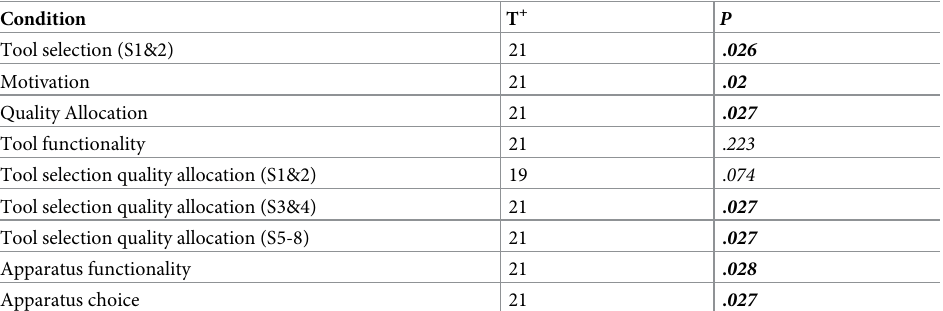
Table 1. Performance across all conditions for the crows across both apparatuses. Results reflect results of Wil- coxon 1-sample signed ranks tests–chance value = 50%. Significant p-values ( < .05) highlighted in bold. S1-8 stands for the number of sessions in this